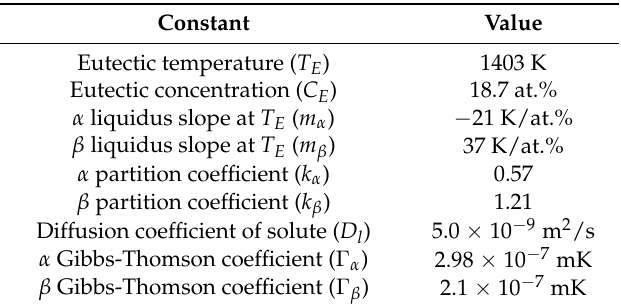
Table 1. Thermal physical parameters of Ni-Ni 3 Sn eutectic